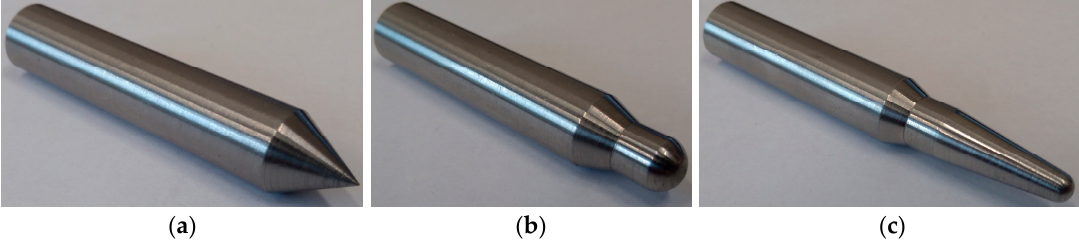
Figure 3. The strikers used in the experiment: ( a ) conical striker, ( b ) hemispherical striker, ( c ) ogival striker. Table 3. Length and weight of the strikers used in the experiment.